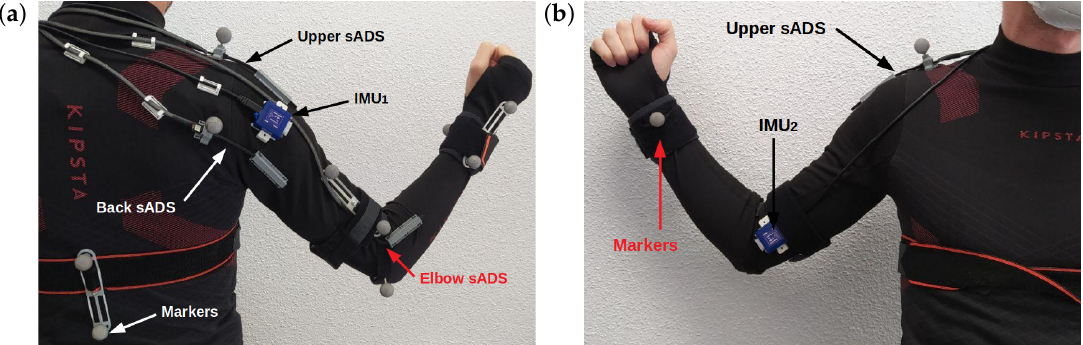
Figure 3. Location of sensors on the compression jacket. ( a ) Back view. The reflective markers are shown in bright grey, the IMU 1 and the two sADS on the shoulder (upper and back) and the sADS on the elbow. ( b ) Front view, which shows two reflective markers and the IMU 2